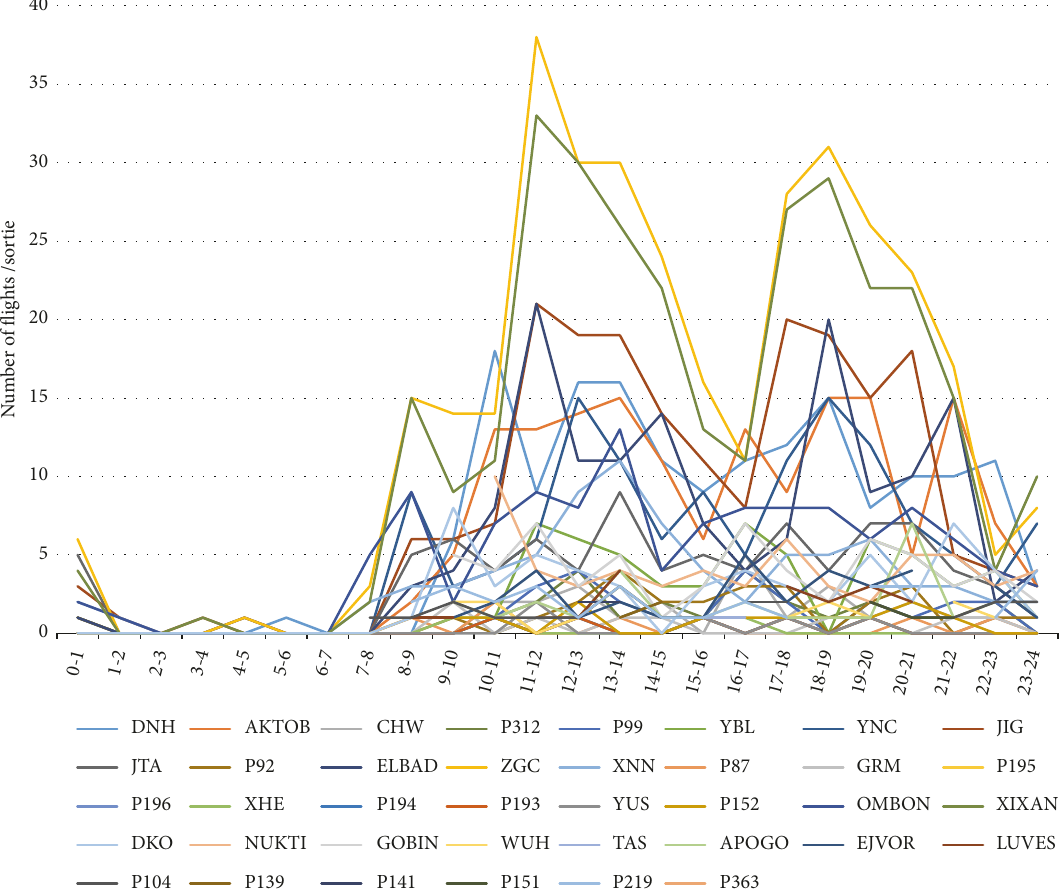
Figure 6: Main airway points flow of Lanzhou control area.